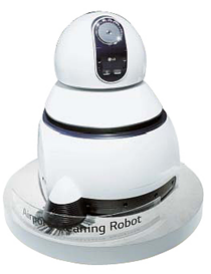
Figure 3. The Cleaning on-line